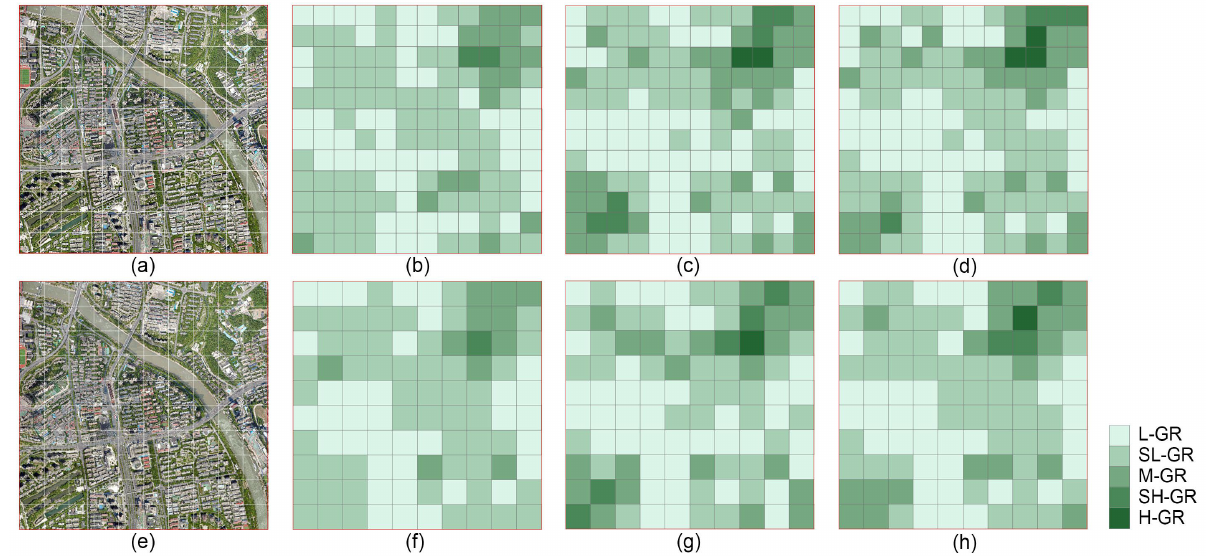
Figure 5. The spatial distribution of GR grades divided by 150 m and 180 m fishnets in a typical region: ( a – d ) the visible light image divided by 150 m fishnet and GR grades identified by DJI, GF1, S2A, respectively; ( e – h ) the visible light image divided by 180 m fishnet and GR grades identified by DJI, GF1, S2A, respectively.